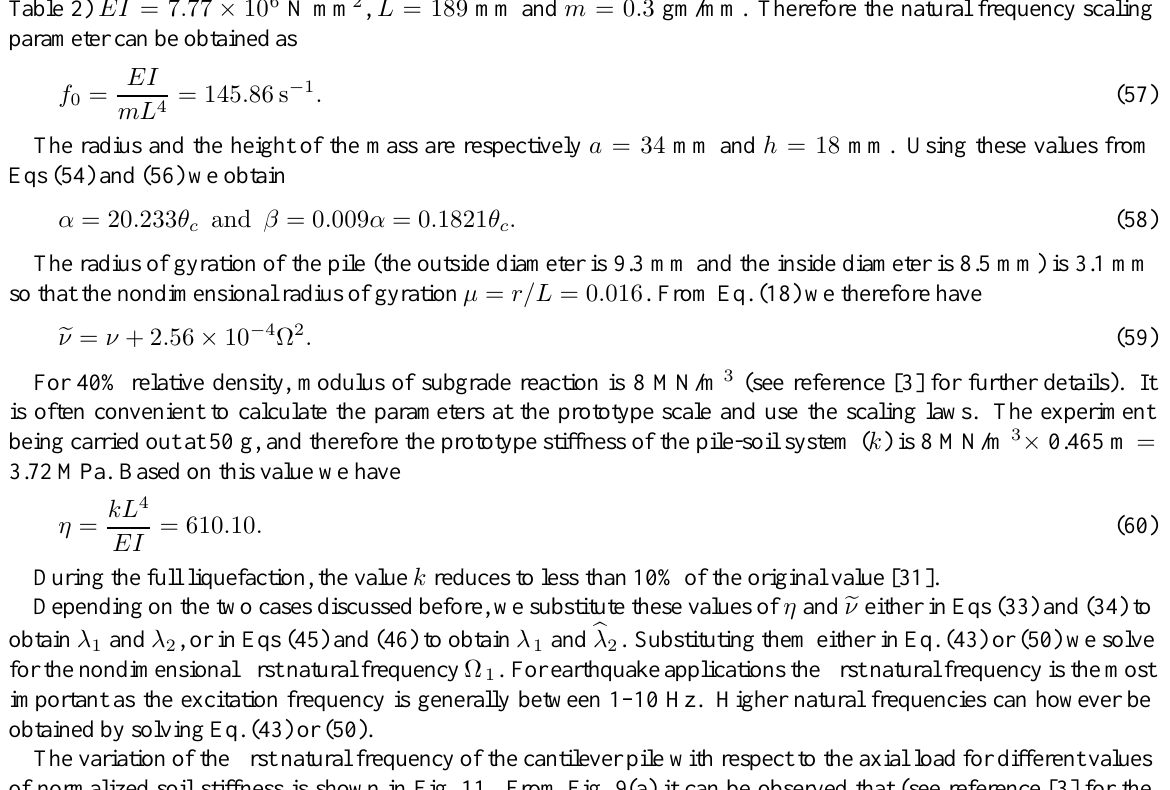
Table 2) EI = 7 . 77 × 10 6 N mm 2 , L = 189 mm and m = 0 . 3 gm/mm. Therefore the natural frequency scaling parameter can be obtained